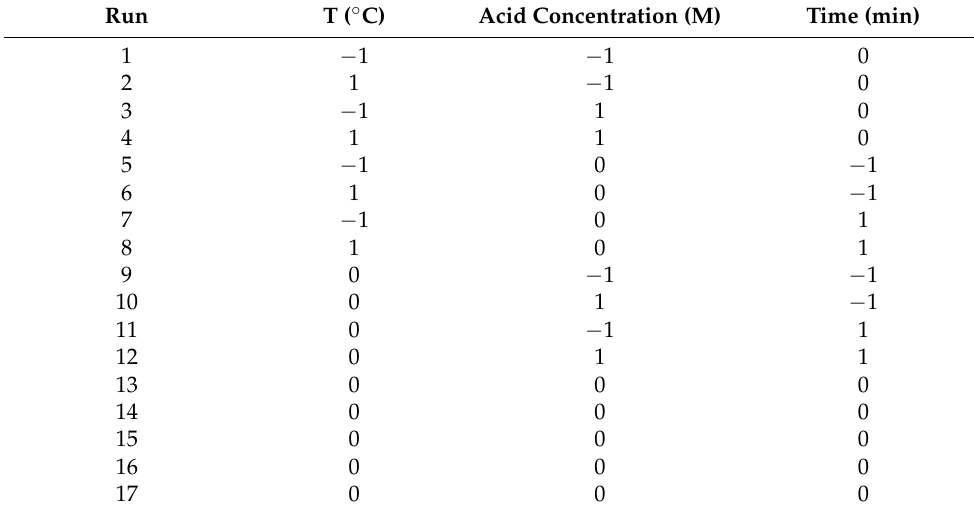
Table 5. Box–Behnken design with experimental design of glucose